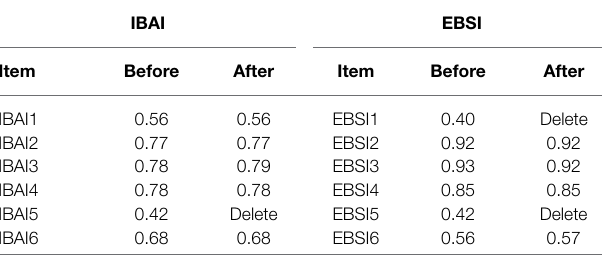
TABLE 2 | Factor loadings